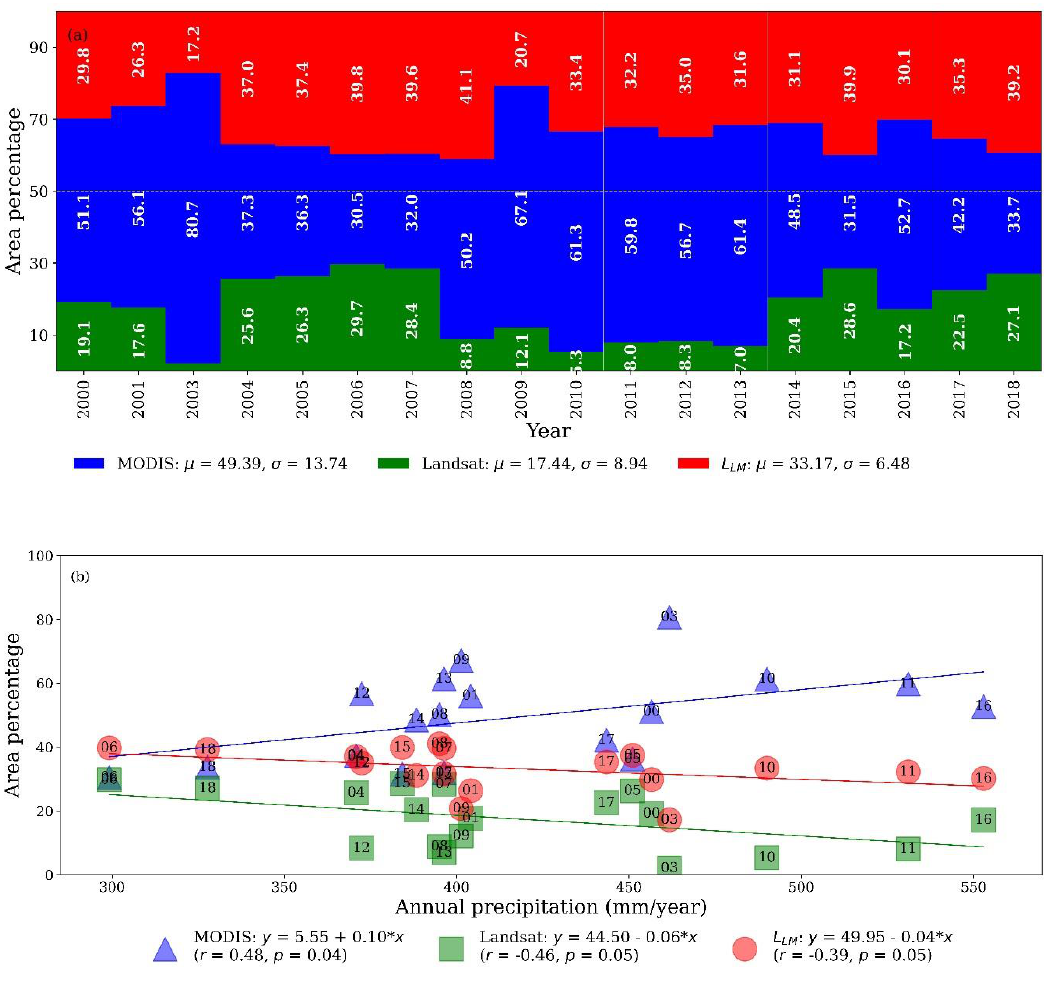
Figure 8. Yearly analysis of multi-sensor data selection for 25-m pixel-level crop yield prediction (2000–2018) by evaluating ( a ) the area percentage and ( b ) its correlation with the annual precipitation (mm / year). The white dashed line shows that the area percentage is 50. µ : mean of population values; σ : standard deviation; r : correlation coefficient. The symbols in (b) are labeled with the last two digits of the year.